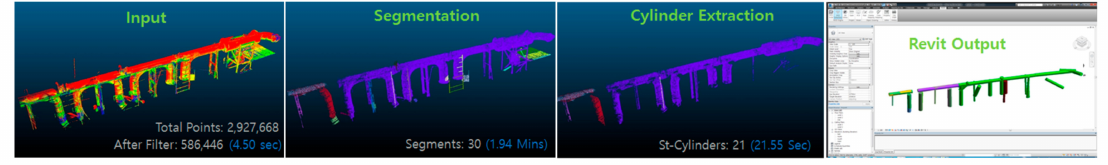
Figure 9. PCD BIM Object Extraction results and error.